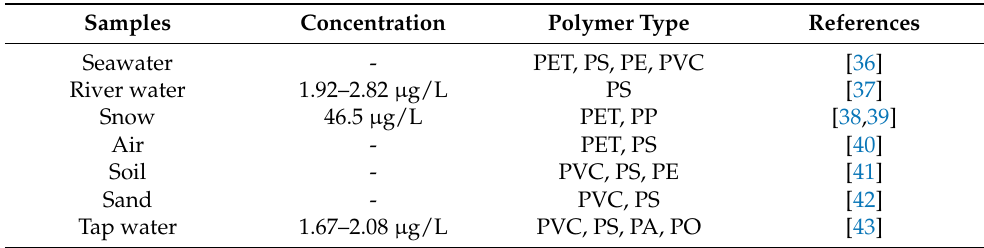
Table 2. List of the studies that successfully detected NPs in environmental abiotic matrices (updated to December 2021). PA: polyamide; PO: